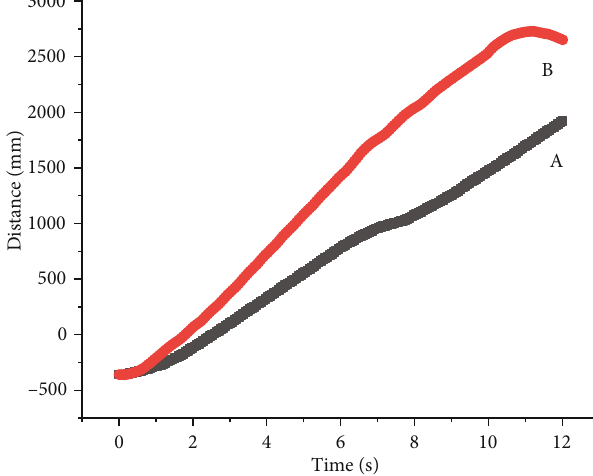
Figure 14: Motion distance of the center of mass of (a) full elbow joint and (b) elbow joint for front legs and knee joint for back legs under the interference of lateral